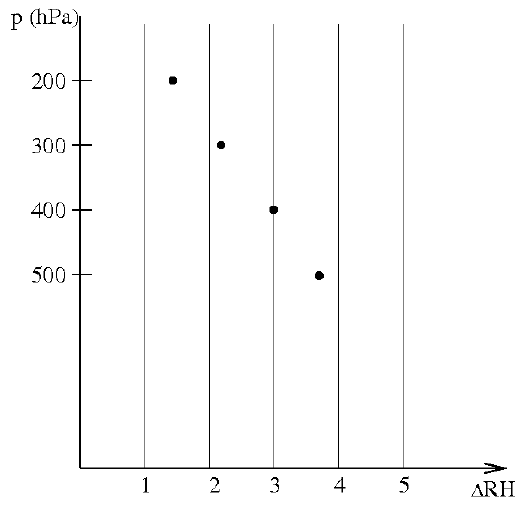
Fig. 3. Relative humidity increase in the upper troposphere corre- Figure 3. Relative humidity increase in the upper troposphere corresponding to increasing 5 sponding to increasing water vapor mixing ratio from Manabe and water vapor mixing ratio from Manabe and Wetherald (1967) by 10% as in Shine and Sinha 6 (1991). 7 Wetherald (1967) by 10% as in Shine and Sinha